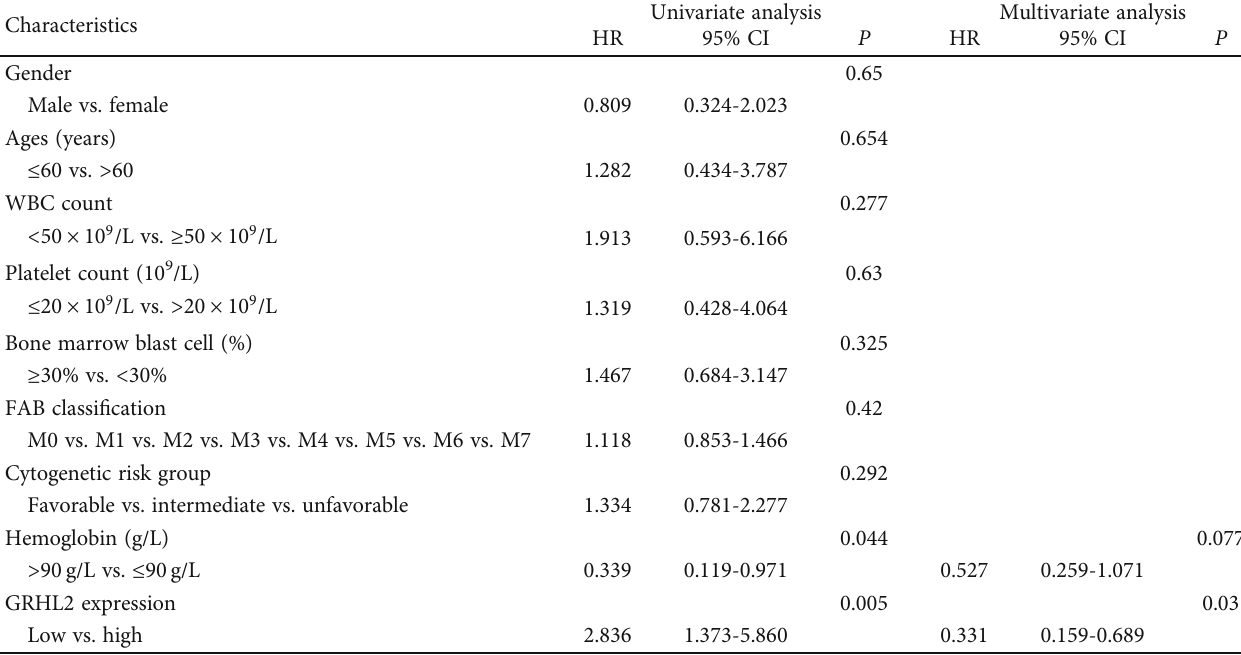
Table 3: Univariate and multivariate analysis of overall survival in patients with acute leukemia ( n = 60 ).